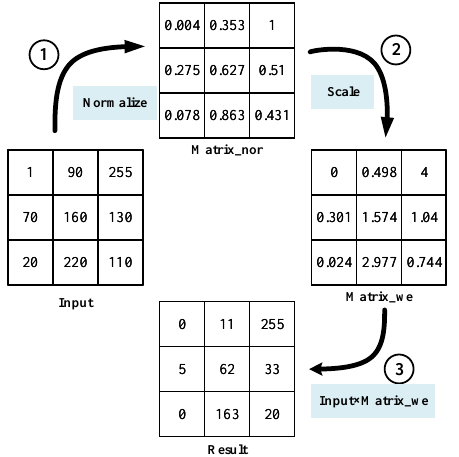
Figure 4. An example: salient point enhancement calculation process.